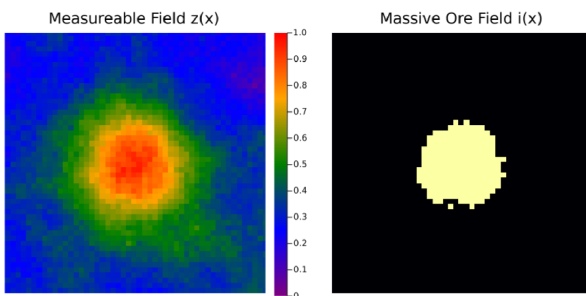
Figure 3. Two-dimensional economic field. The massive ore field i(x) shows where the measurable field z(x) exceeds the economic threshold z threshold